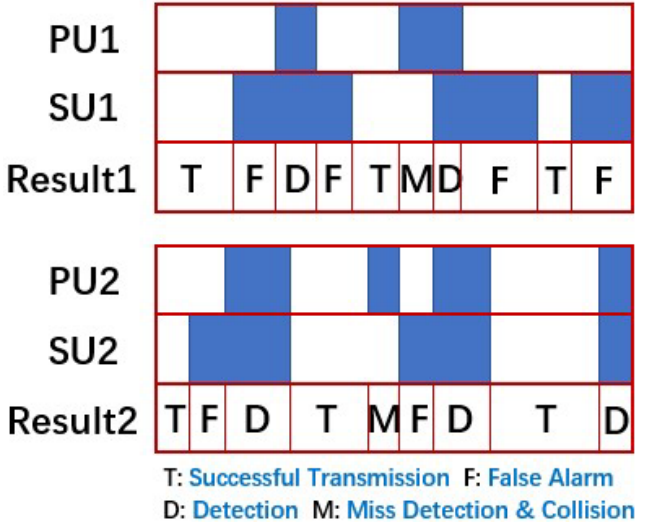
Figure 1. Impacts of different PU activities on sensing results.